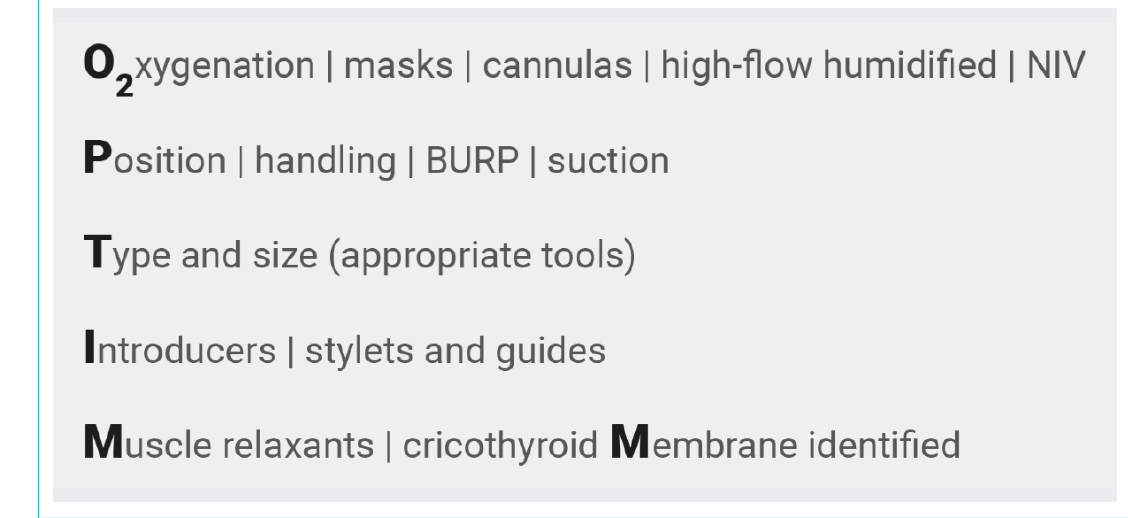
Figure 3: The O 2 PTIM acronym highlights the importance of adjuncts to optimise technical skills. BURP: backward, upward, and rightward la- ryngeal pressure; NIV: noninvasive